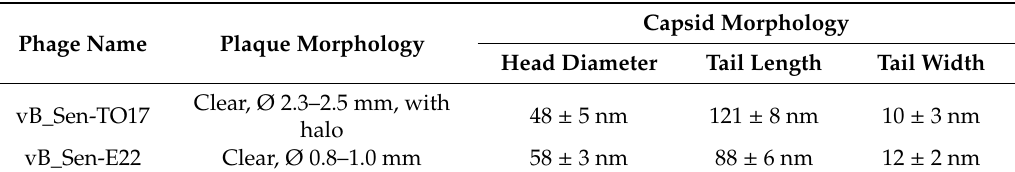
Figure 1. Morphology of plaques of vB_Sen-TO17 ( A ) and vB_Sen-E22 ( B ), formed on a lawn of the S. Typhimurium 13 host. A size bar (representing 1 cm) is shown at the bottom of panel A. Table 1. Morphological characteristics of phages vB_Sen-TO17 and vB_Sen-E22. Experiments were performed using S . Typhimurium 13 as a host.